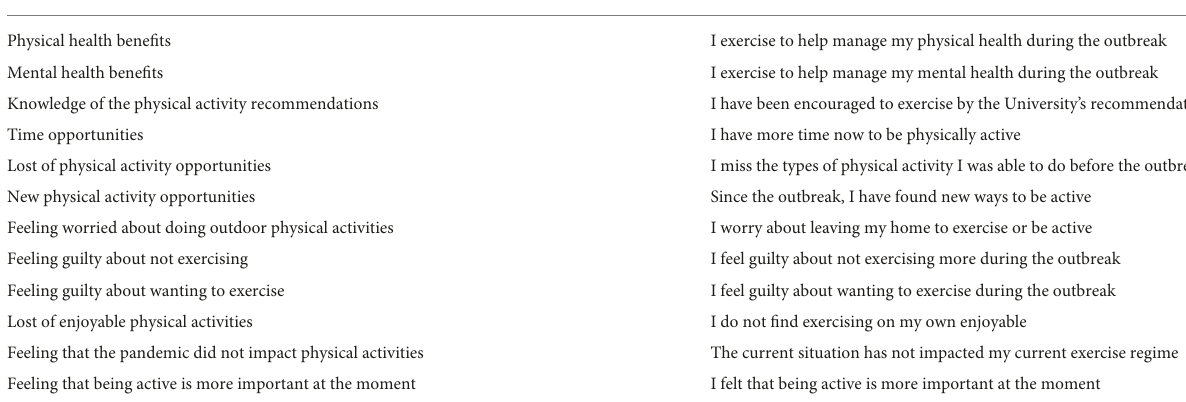
TABLE 1 Themes and statements asked in the attitudes and feelings questionnaire.